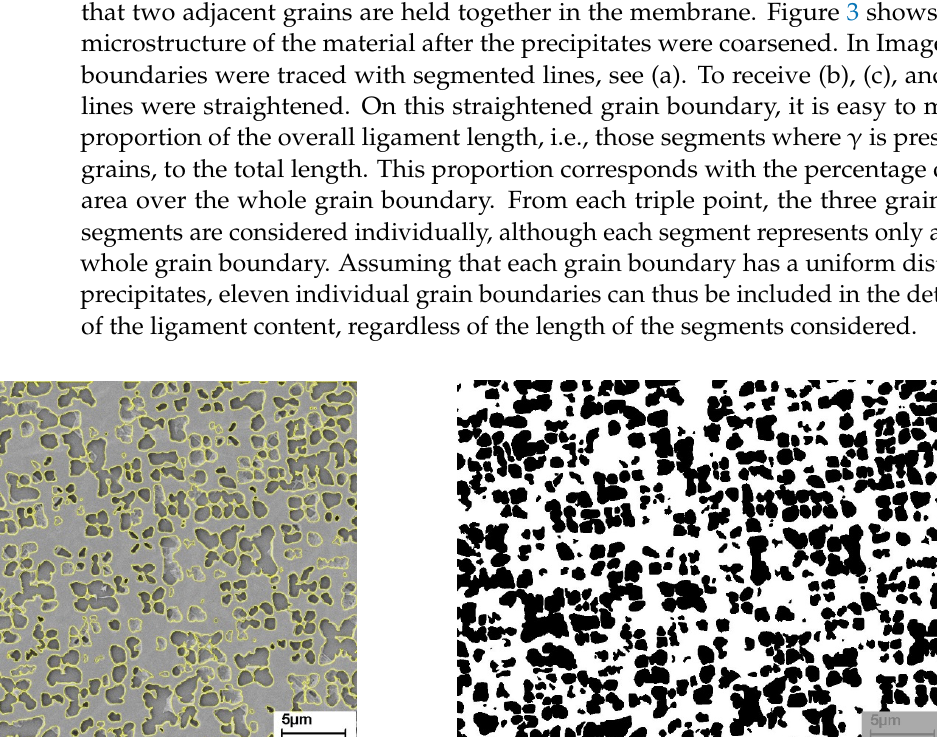
Figure 1. Visualization of the strain in loading direction in specimen 5 for the last frame before the fracture. Three lines each were defined to obtain the strain in the area of the porous structure. Using the frame with the largest elongation (last frame before fracture), the transition between grip section and porous structure is best distinguished.